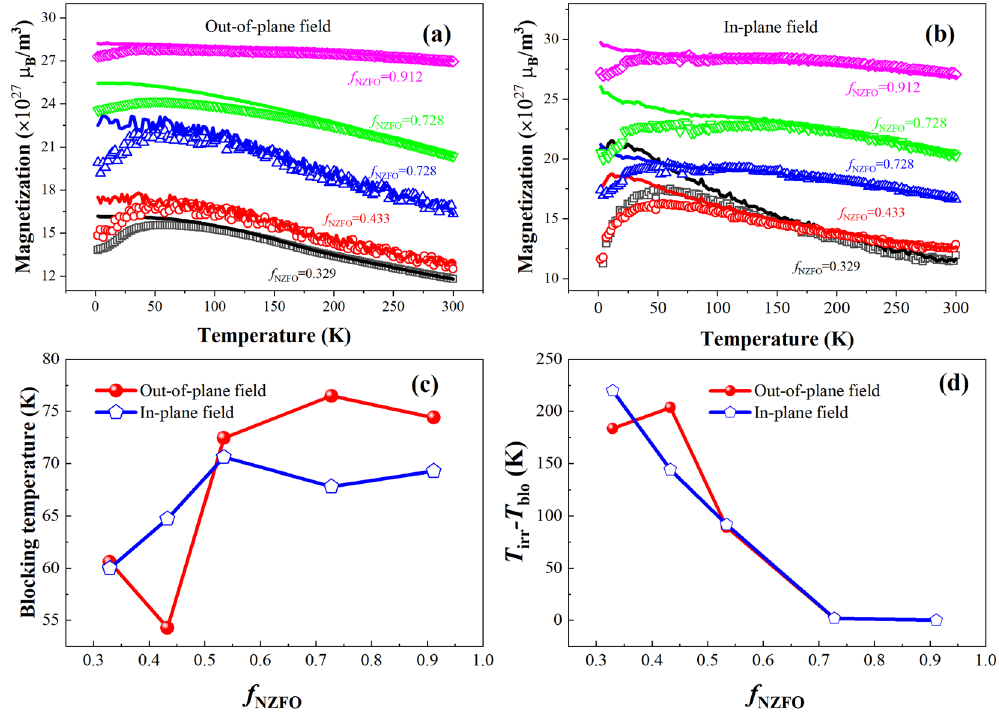
Figure 4. ZFC-FC curves of the BTO-NZFO composite thin films with different ferrite contents under ( a ) out- of-plane and ( b ) in-plane magnetic fields. ( c ) The blocking temperature and ( d ) the value of T irr − T blo of the composite thin films as a function of ferrite